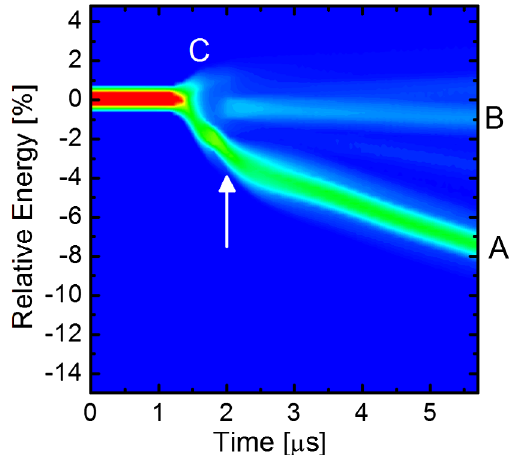
FIG. 10. The evolution of the energy distribution of the electron beam obtained by the numerical simulation under the DCD parameter of 9 . 4 μ m. The arrow indicates the timing of the cavity detuning condition altering from 9 . 4 μ m to 0 μ